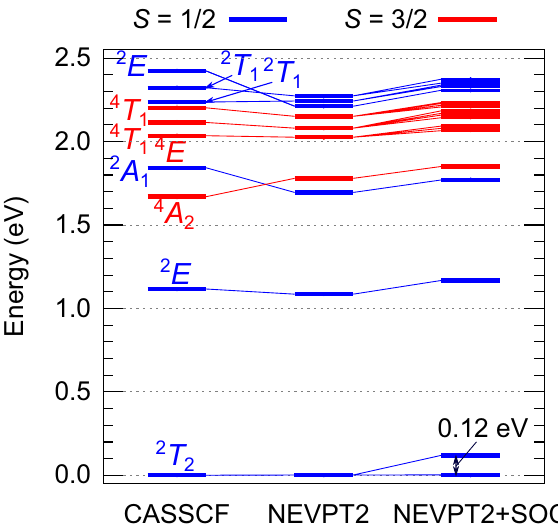
Figure 2. Low-energy excitation energies for high-temperature GaMo 4 S 8 . The spectrum was calculated using an [Mo 4 S 16 ] 19- embedded cluster model (CAS(11e,12o)). Both CASSCF and NEVPT2 values (also with SOC for the latter) are given in eV. Four quartets and six doublets were included in the state-averaging procedure. Notations according to T d point group symmetry are